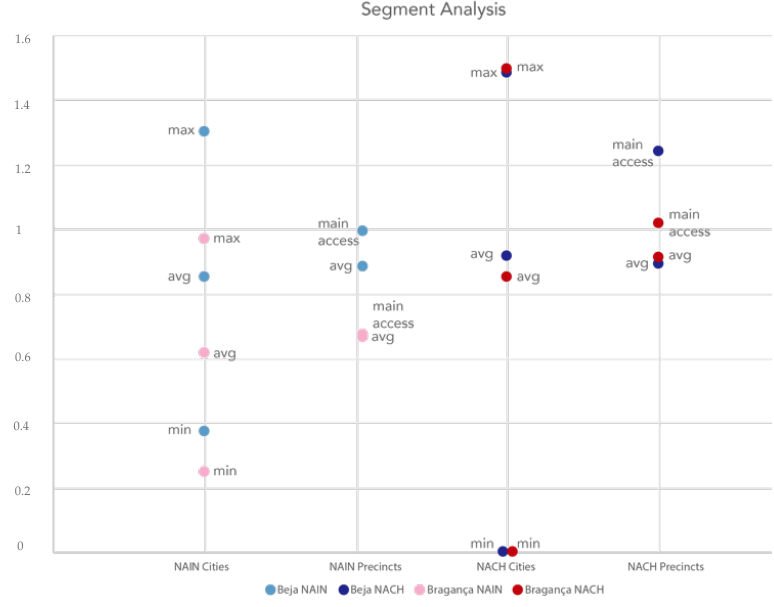
Figure 7. Segment analysis summary.